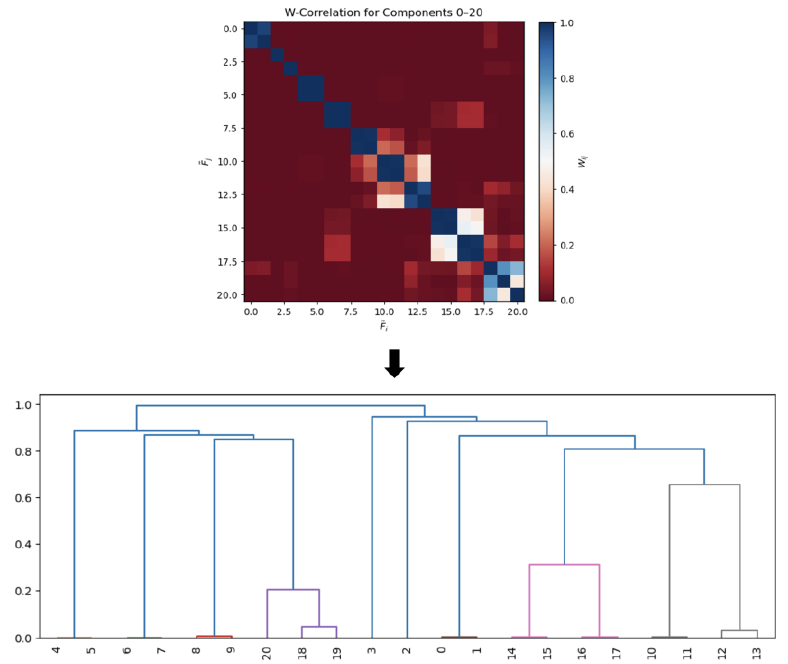
Figure 12. Schematic diagram of the component grouping algorithm implementation.